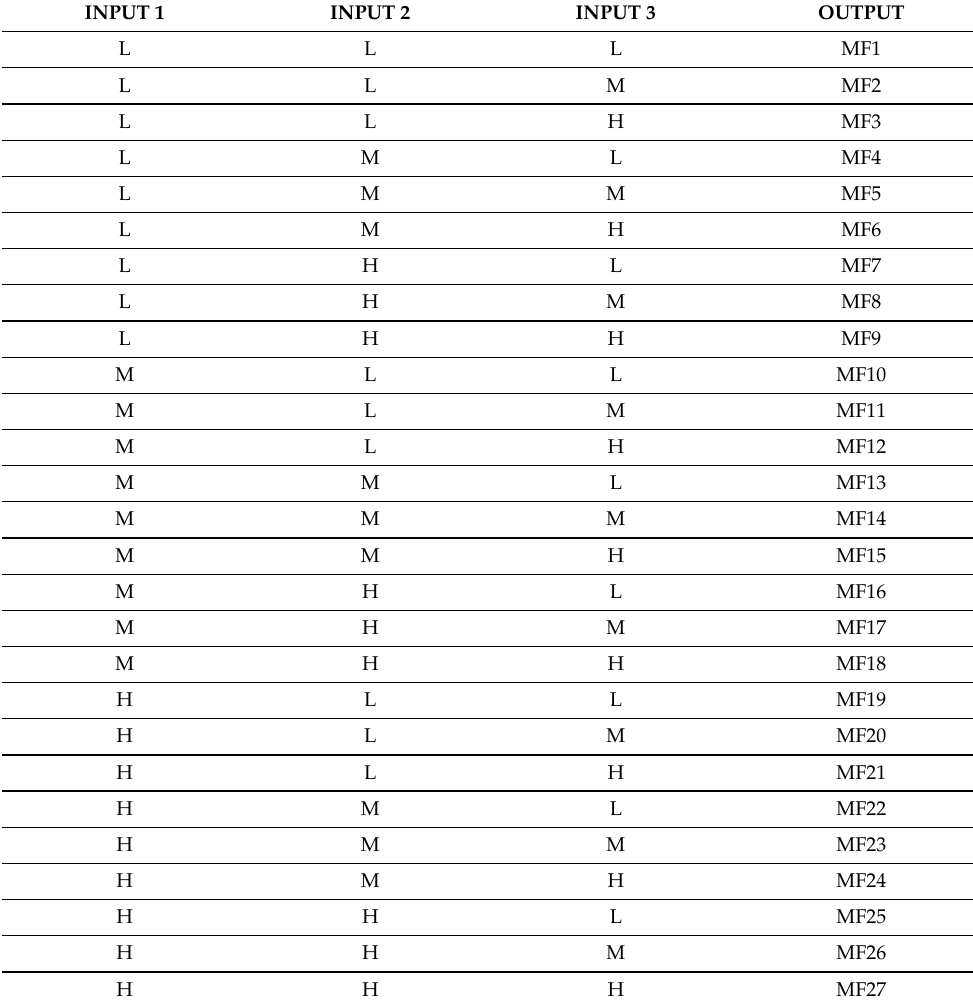
Figure 10. Tuned fuzzification membership functions of the VFC-based fuzzy controller. Table 5. Tuned fuzzy rules of VFC